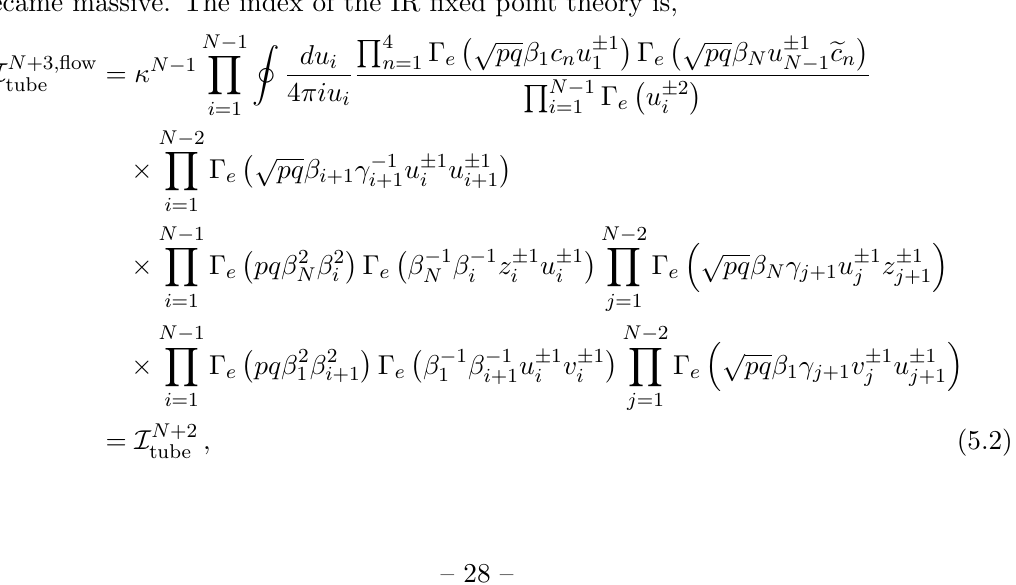
(top) which is the UV theory deformed N +3 (bottom), which is the theory we (cid:13)ow to in the N +2